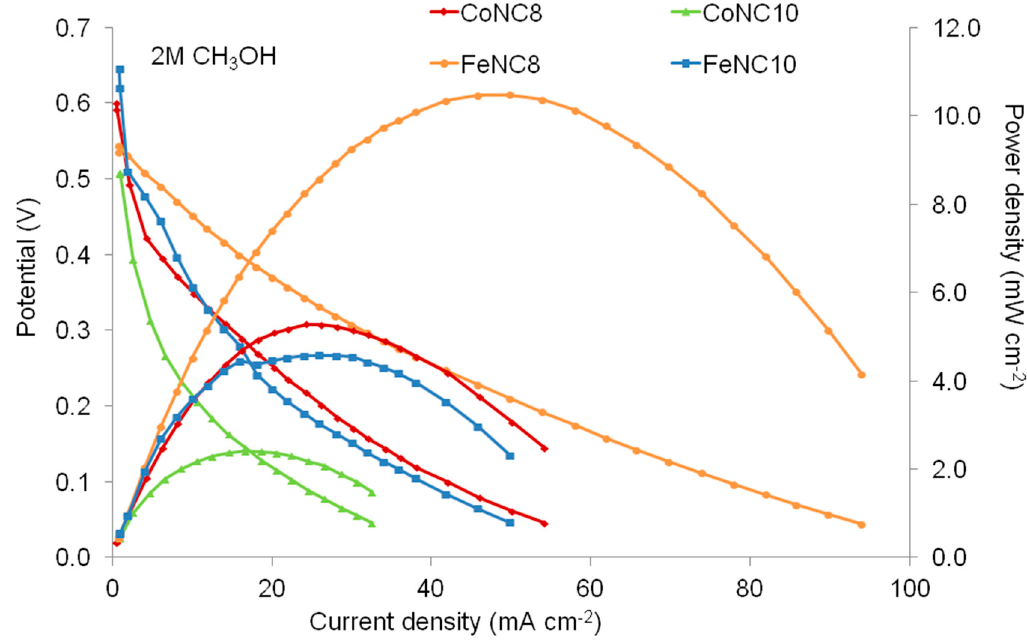
Figure 10. Polarization and power density curves obtained for CoNC8, CoNC10, FeNC8, and FeNC10 at the cathode of the DMFC by using a 2 M methanol concentration at 90 °C.